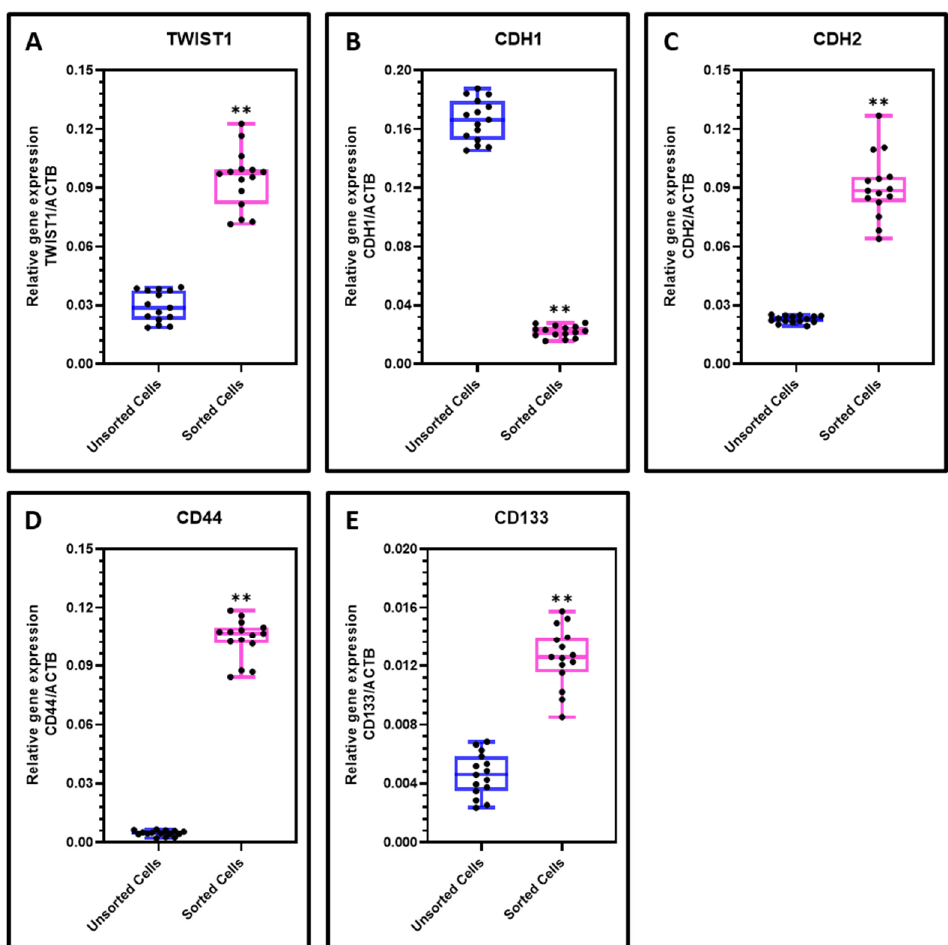
Figure 2. RT-qPCR analysis for gene expression. ( A – C ) Comparative analysis of EMT related genes TWIST1, CDH1, and CDH2 in OSCC cells and sorted CD44+ cells; ( D , E ) Comparative analysis of CSC markers CD44 and CD133 (PROM1) in OSCC cells and sorted CD44+ cells. Experiments were performed in triplicates for all five samples independently. ns not significant, ** p < 0.01 .